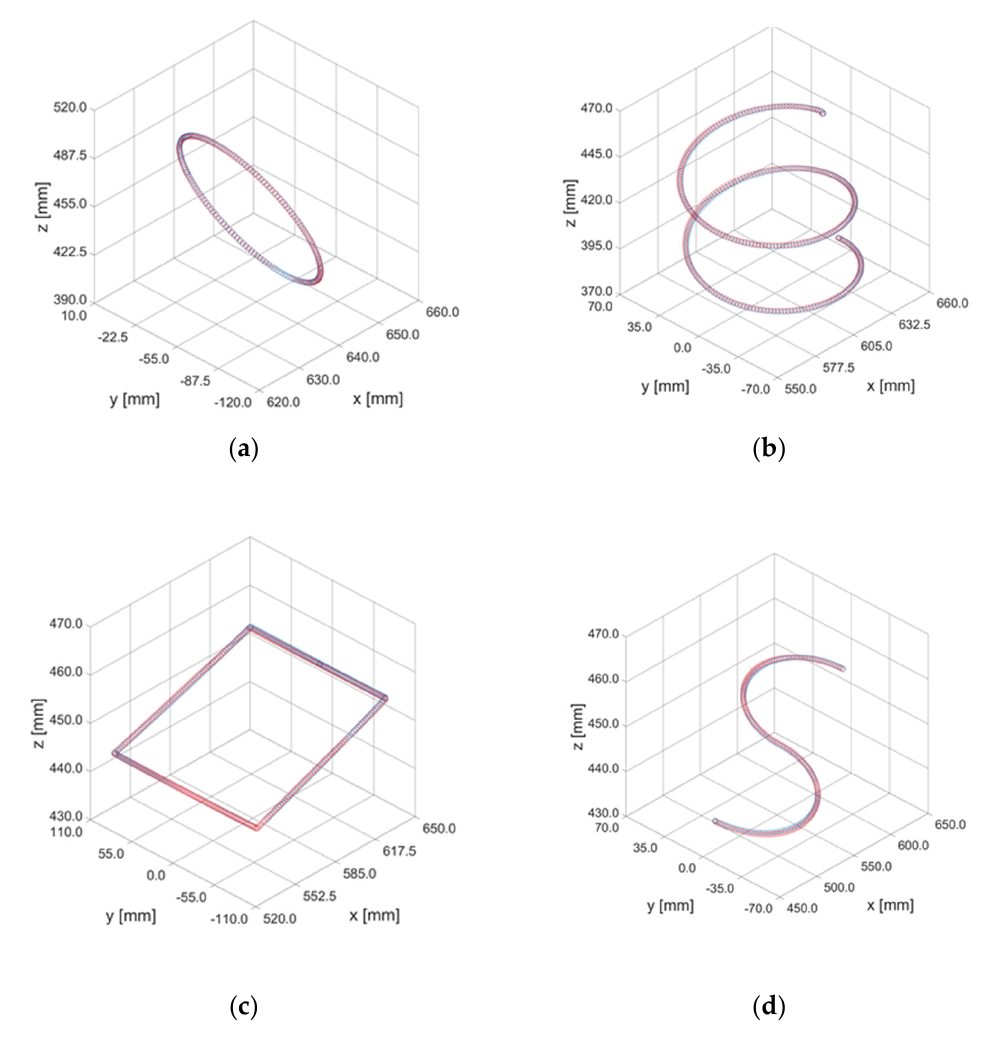
Figure 13. Robot (blue) vs. IK procedure (red) for the implemented trajectories: ( a ) circle in the Y-Z plane; ( b ) spiral X-Y along Z-axis; ( c ) rectangle in the X-Y plane ( d ) S-shape in the X-Y plane.